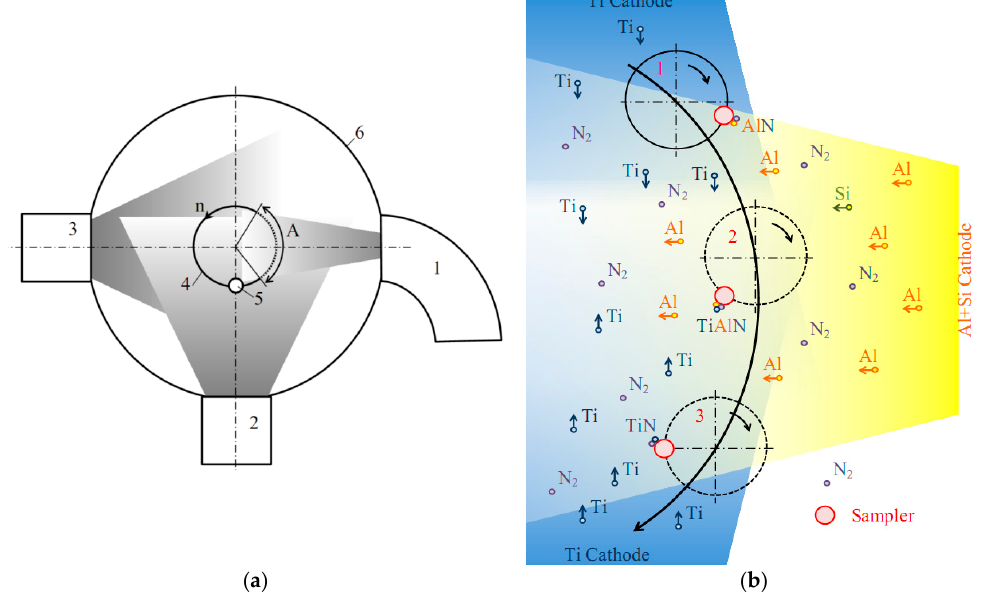
Figure 5. Diagram showing the VIT-2 unit ( a ) and coating deposition process ( b ).